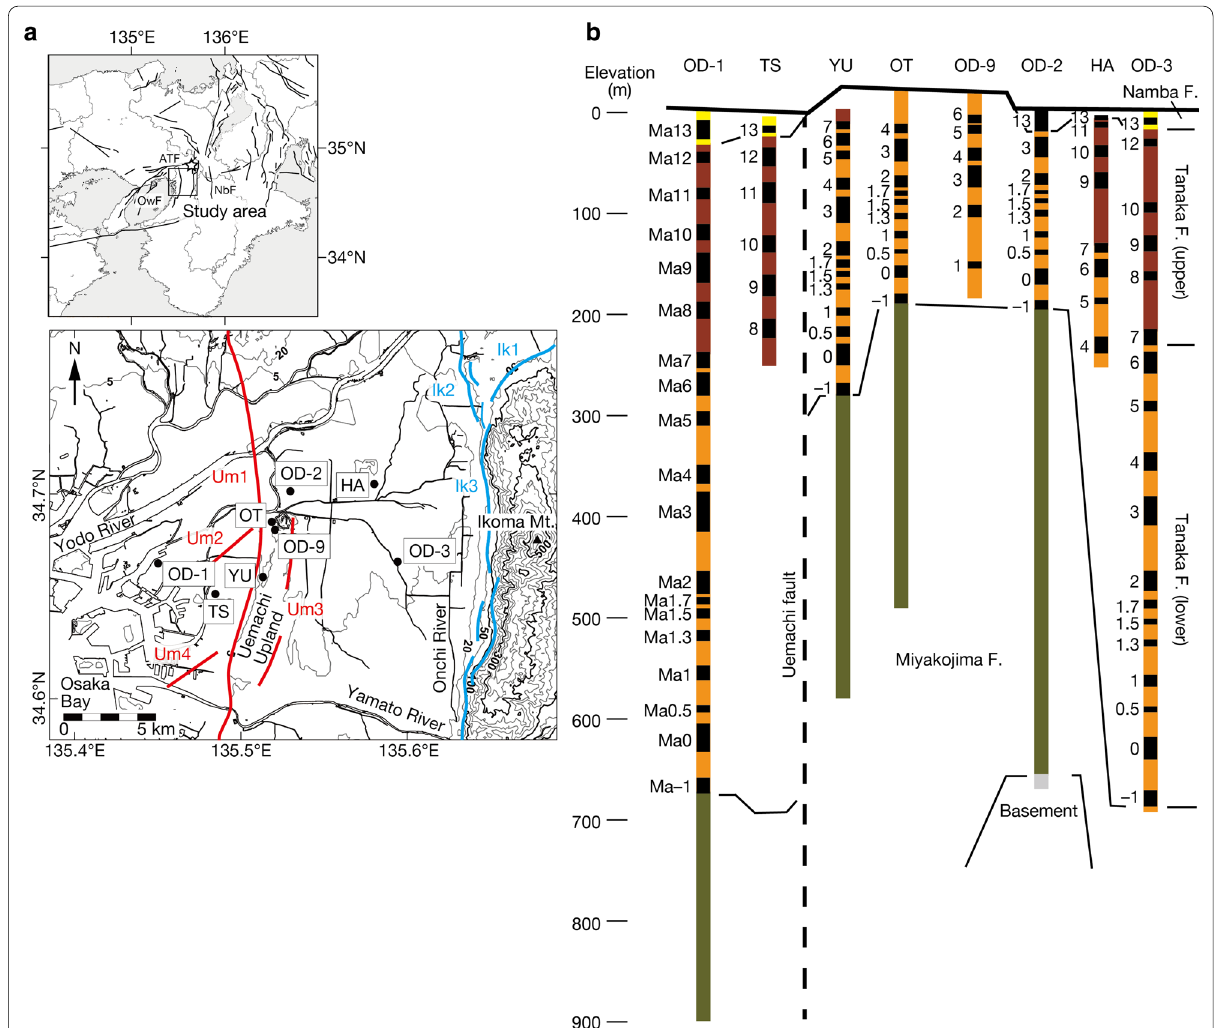
Fig. 1 a Locations of the drilling sites on the Osaka Plain referred to in this study. Faults and flexures of the Uemachi fault zone, as illustrated in red, include the Uemachi fault (Um1), Sakuragawa flexure (Um2), Nagai fault (Um3), and Suminoe flexure (Um4), and those of the Ikoma fault zone, as illustrated in blue, include the Katano fault (Ik1), Hirakata fault (Ik2), and Ikoma fault (Ik3) (Headquarters for Earthquake Research Promotion of MEXT 2001, 2004). The Butsunenji-yama and Taguchi faults, and the Sakamoto, Kumedaike and Konda faults are located to the north and the south of the mapped area, respectively. The inset indicates the location of the study area. Inland active faults in and around the Kinki region (Headquarters for Earthquake Research Promotion of MEXT 2005) are also shown in the inset. ATF, OwF, and NbF represent faults and flexures of the Arima-Takatsuki fault zone, Osaka-wan fault zone, and Nara Basin eastern edge fault zone, respectively. The epicenter of the 2018 northern Osaka earthquake proposed by Kato and Ueda (2019) is indicated by a star. b Columnar sections of the OD-1, TS, YU, OD-9, OT, OD-2, HA, and OD-3 drilling cores (partially modified from Uchiyama et al. 2001). Basement rock, Miyakojima Formation, lower Tanaka Formation, upper Tanaka Formation, Namba Formation, and marine clay layer are illustrated in gray, brownish green, orange, brown, yellow, and black,